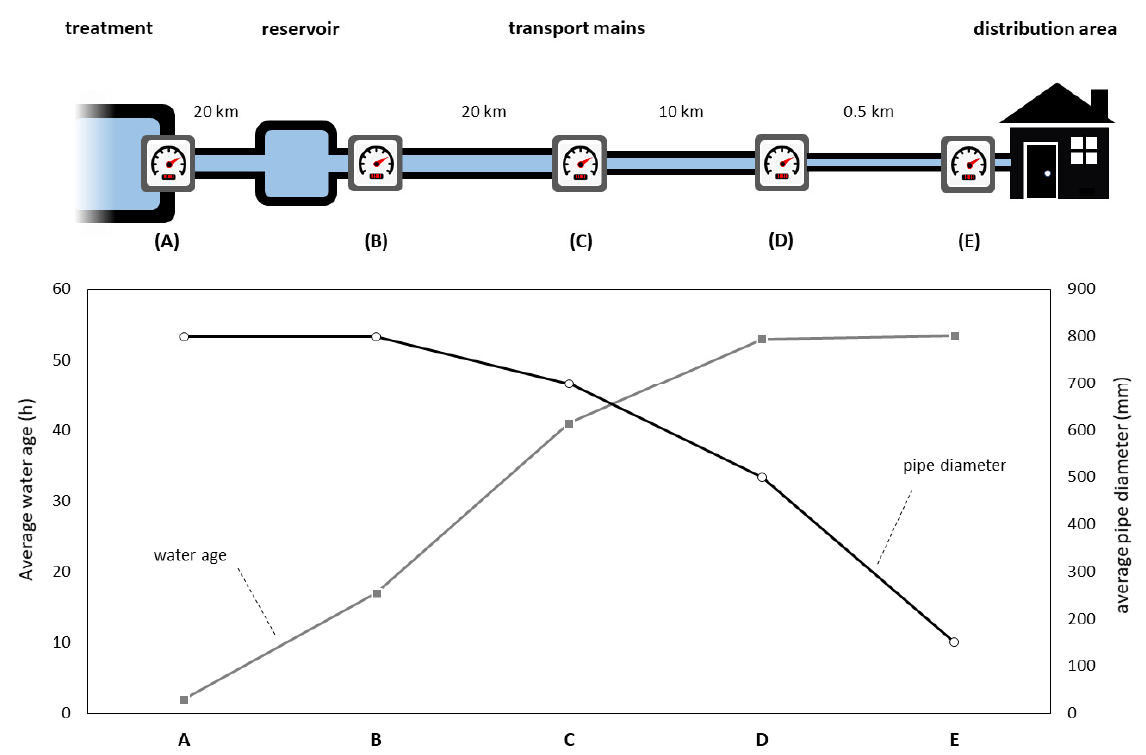
Figure 1. Characteristics of sampling points in the studied DWDS. ( Top ) Schematic overview of transport mains and distribution system piping layout, indicating the sampling point locations (A–E). ( Bottom ) Change in average water age and pipe diameters over the studied water trajectory from sampling locations A to E.